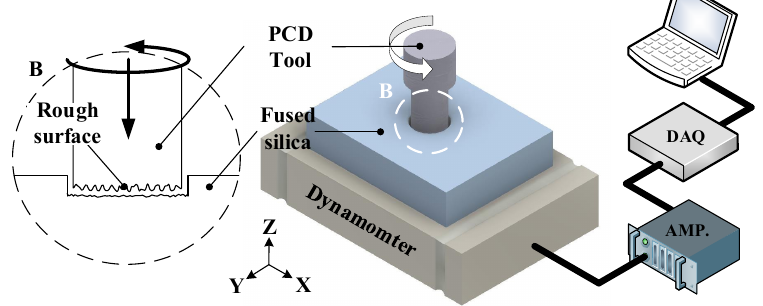
Figure 2. Schematic illustration of the microdrilling